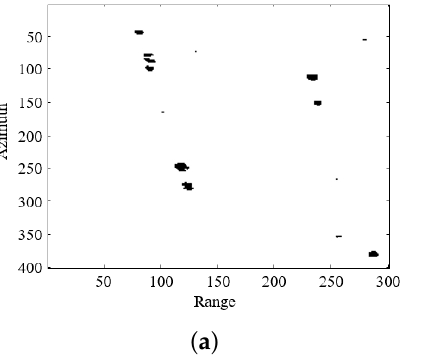
Figure 9. Results comparison between P-band and C-band. ( a ) P-band and ( b )